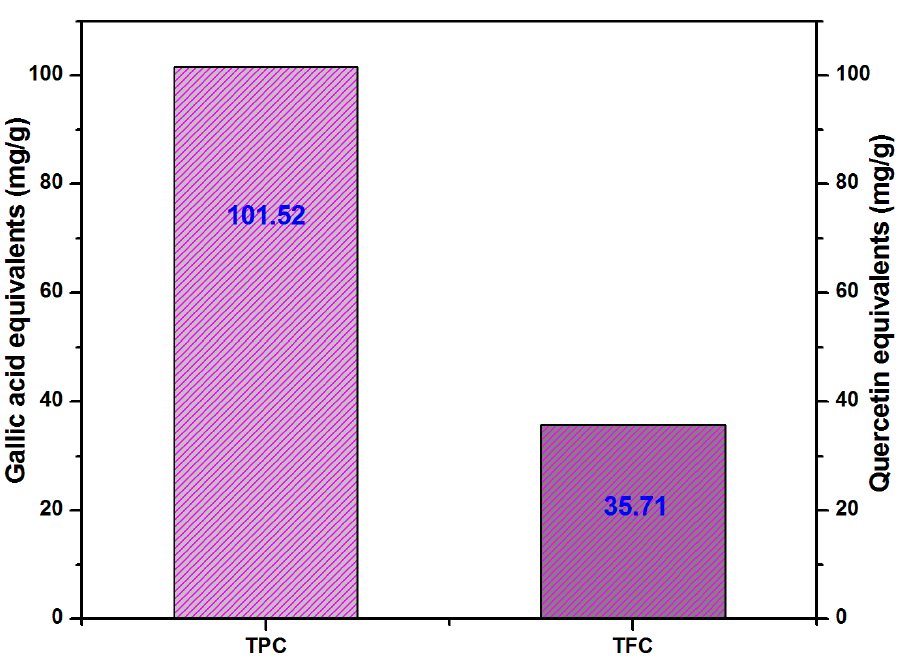
Figure 2. TPC and TFC of C. tagal plant extract.